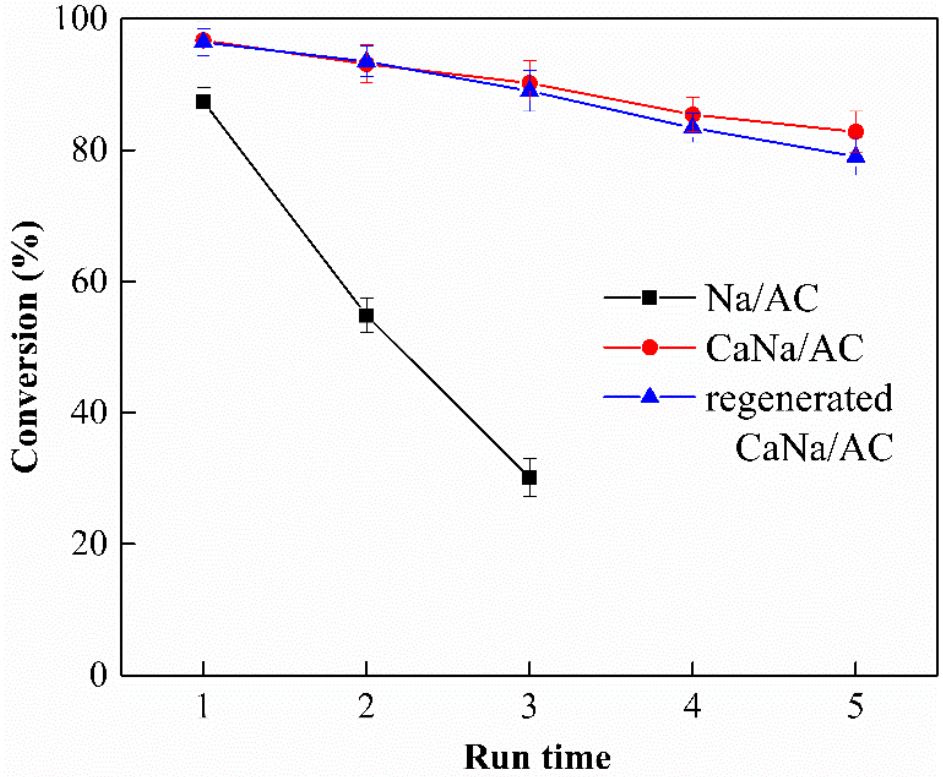
Figure 7. The reusability of Na/AC and CaNa/AC in the transesterification.